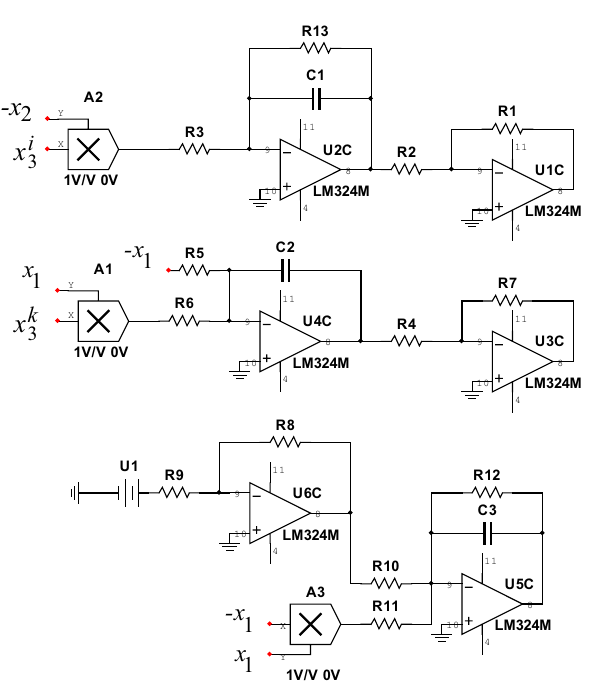
Figure 10. System (8) circuit simulation